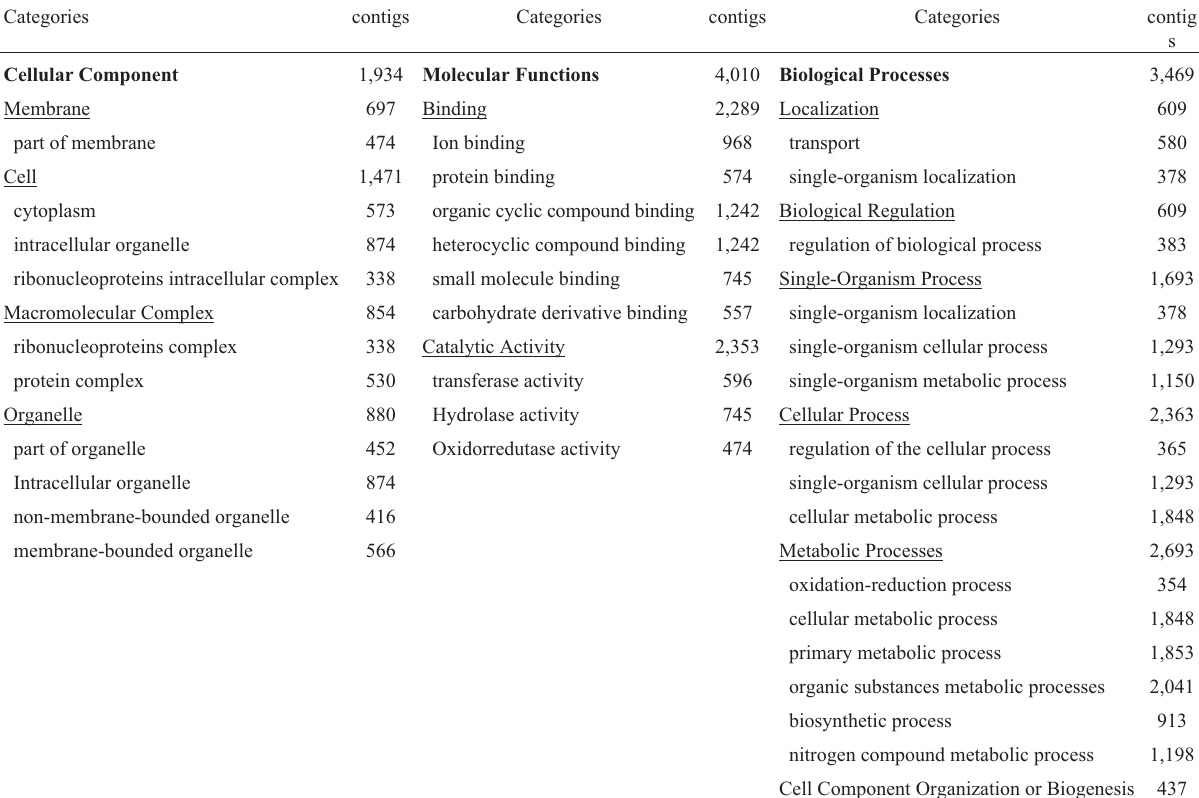
Table 2 - Summary of acyclic graphics for the arrangement of GO terms for cellular components, molecular functions and biological